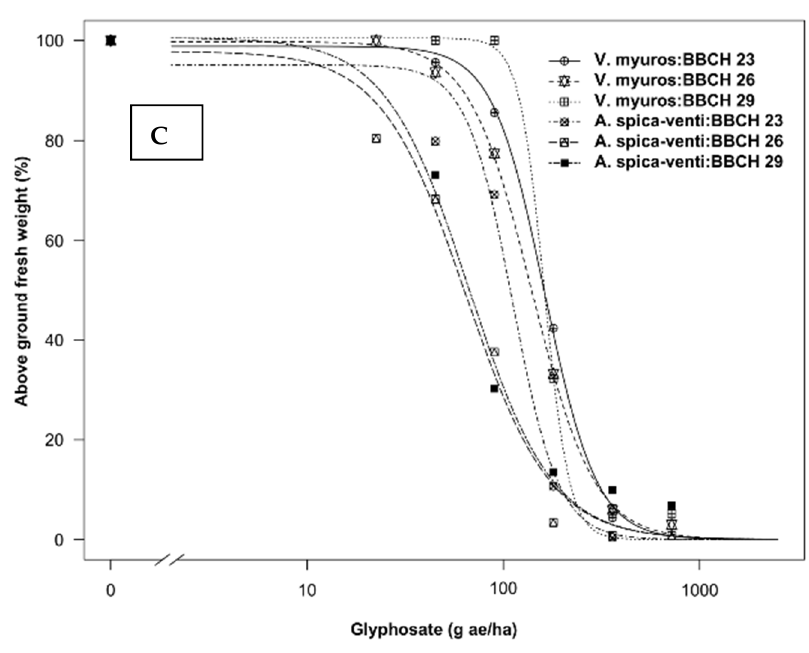
Figure 1. Glyphosate dose-response bio-assay on above-ground fresh weight represented as percent- age of untreated control of Vulpia myuros and Apera spica-venti in Experiment 1 ( A ) Experiment 2 ( B ) and Experiment 3 ( C ). Table 2. Glyphosate doses (g a.i. ha − 1 ) providing 50% reduction in fresh weight (GR 50 ) of Vulpia myuros and Apera spica-venti estimated using log-logistic Equations (1) or (2). Standard errors are presented in the